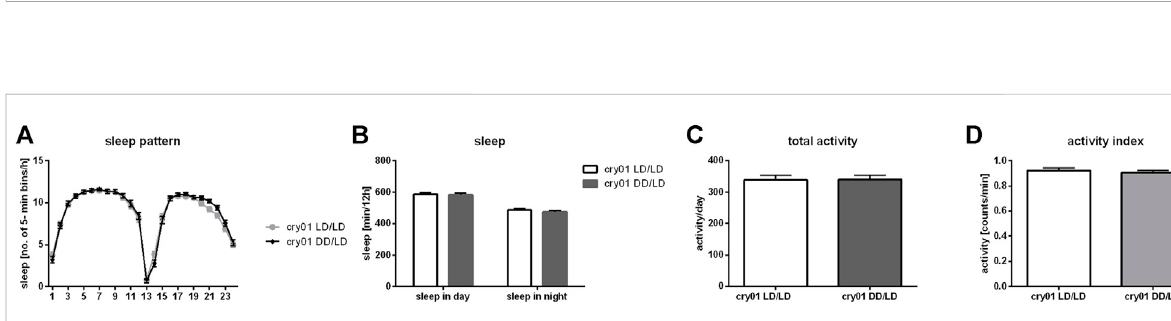
Cryptochrome is a key factor in larval light absorbance affecting behavior in adults. cry 01 mutants kept in darkness during development did not show changes in (A) sleep pattern, (B) sleep level nor (C) activity level. (D) Activity index measured as ratio of total activity per day and number of minutes awaked. Mean ±